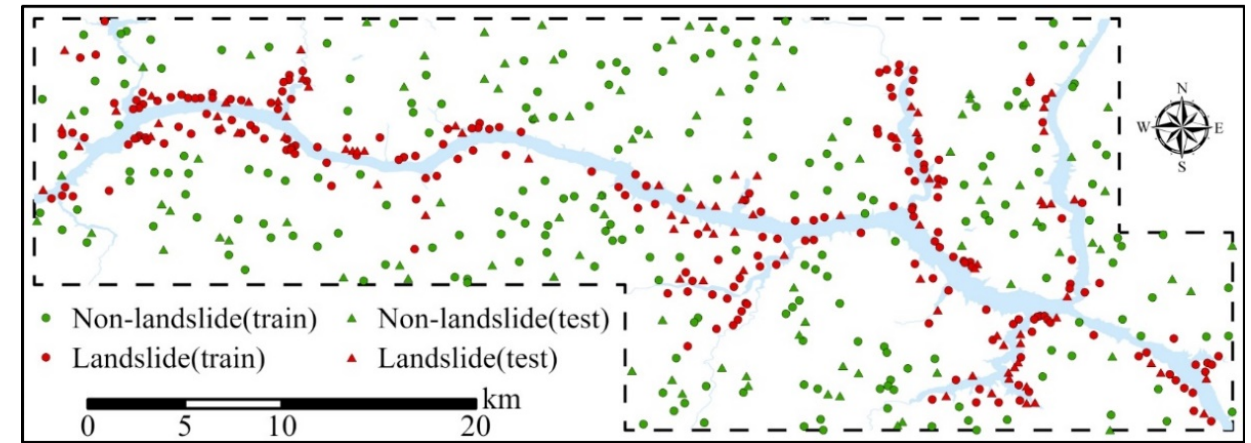
Figure 5. Distribution of the training and testing datasets.